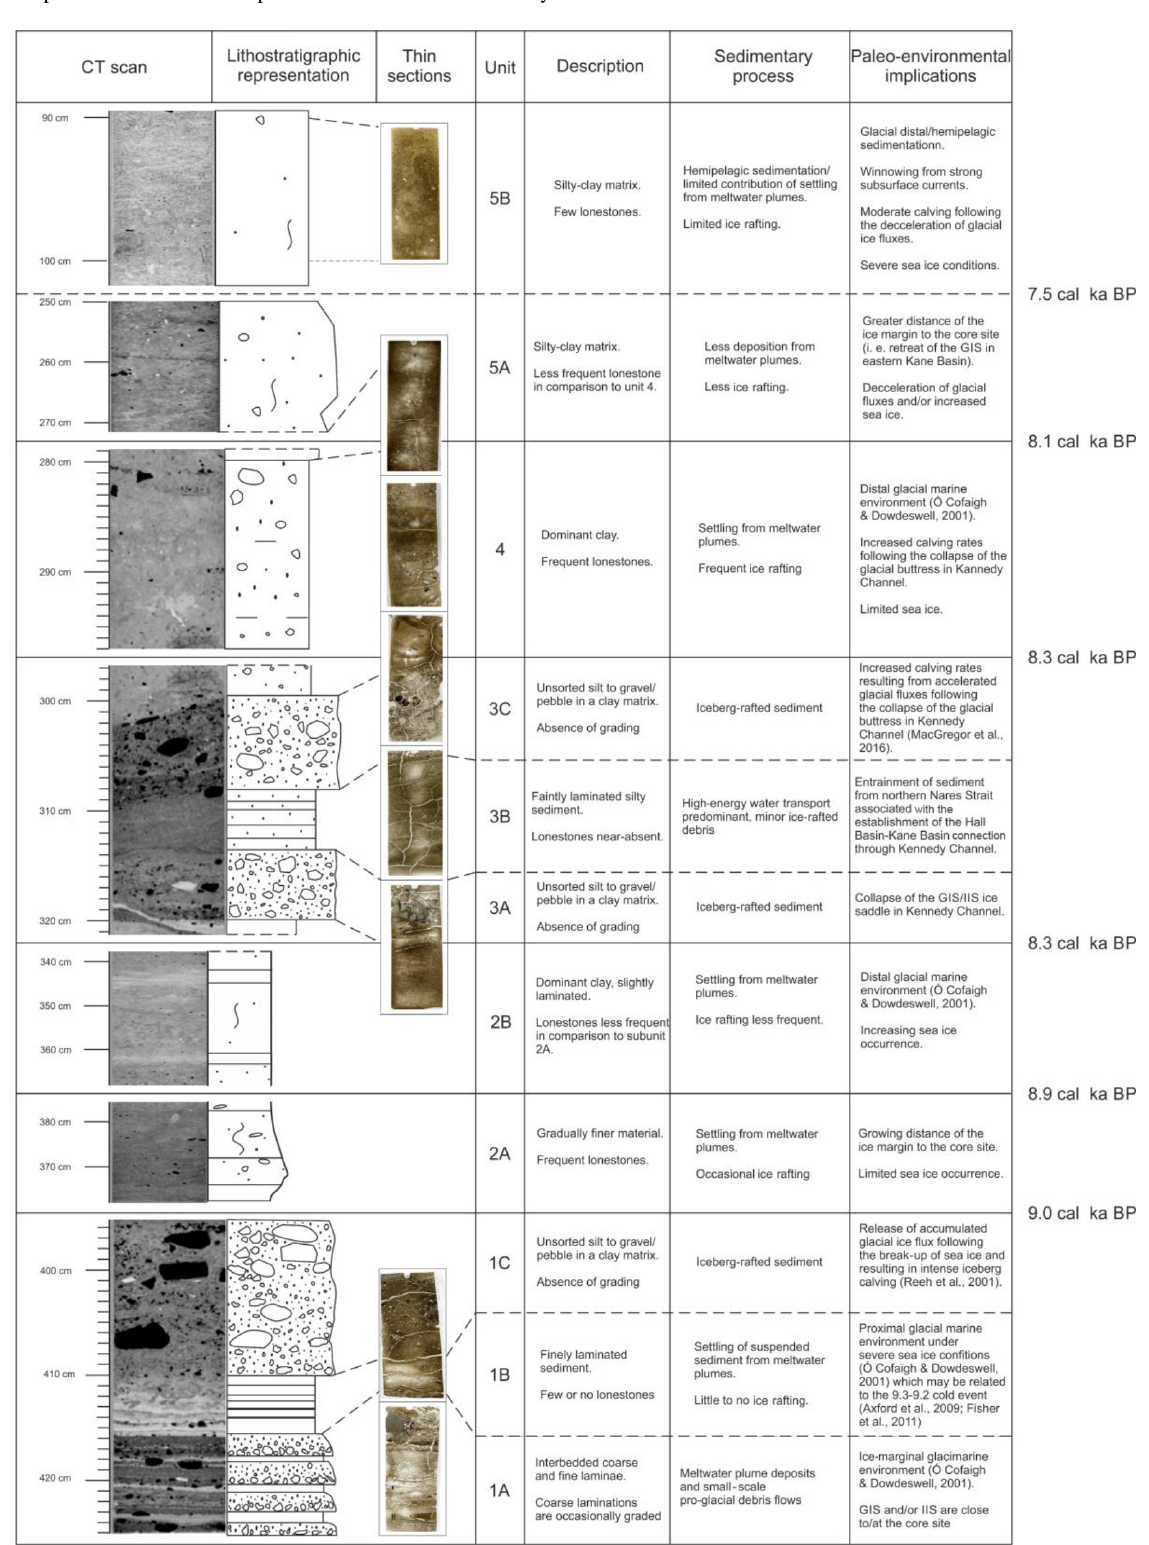
Table 2. Details of CT scans and thin sections for each lithologic unit of core AMD14-Kane2B and summarised descriptions and interpreta- tions. The paleo-environmental implications discussed in this study have been outlined